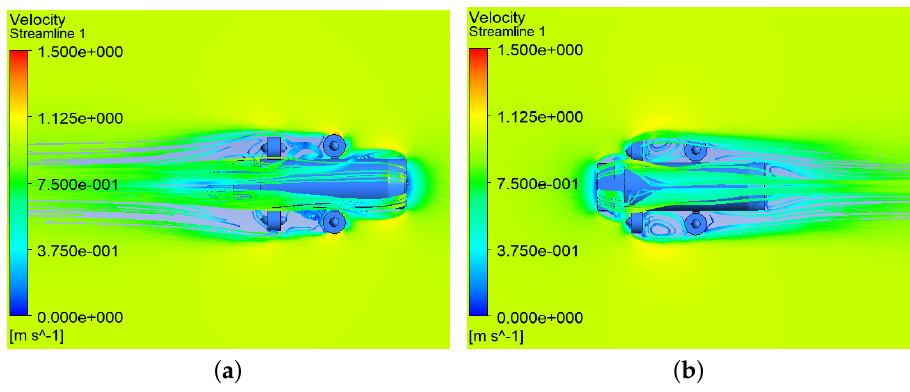
Figure 6. Comparison of flow field streamlines around the underwater vehicle model. ( a ) Flow field streamlines diagram around the underwater vehicle moving in a straight line along the positive x -direction; ( b ) flow field streamlines diagram around the underwater vehicle moving in a straight line along the negative x